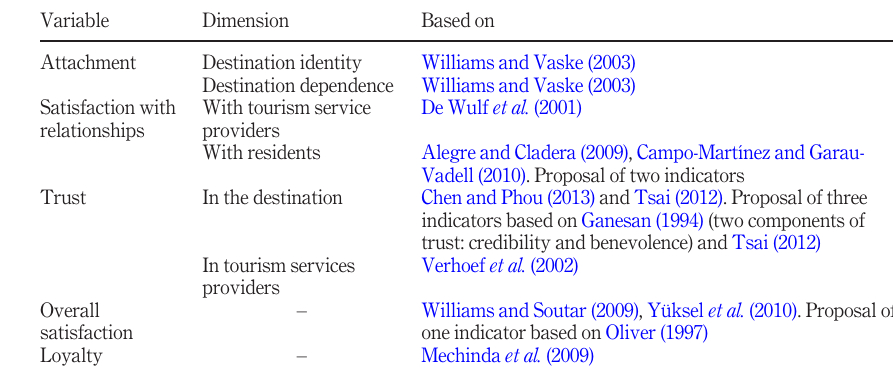
rural tourism. The authors also mention some limitations of this method, which are the sample representativeness, the low response rate, technical dif fi culties and inactive or inaccurate e-mail addresses. Another problem identi fi ed by Baena et al. (2010) is if people answer the on line questionnaire more than once, considerably altering the survey ’ s results.